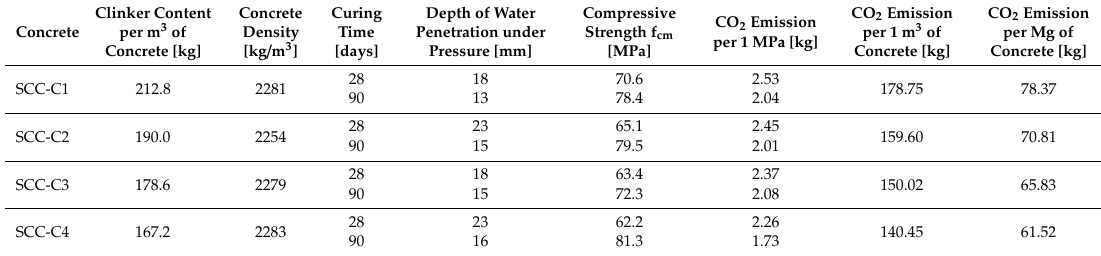
Table 12. Properties of SCC concretes with CO 2 emission